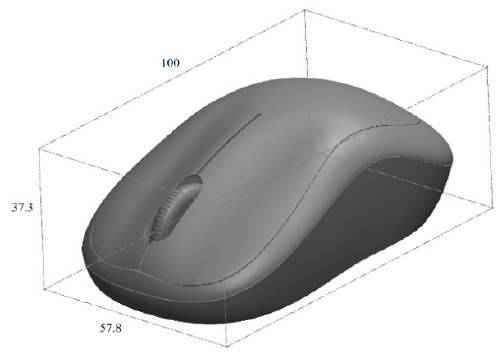
Figure 2. Isometric image of the reference mouse.